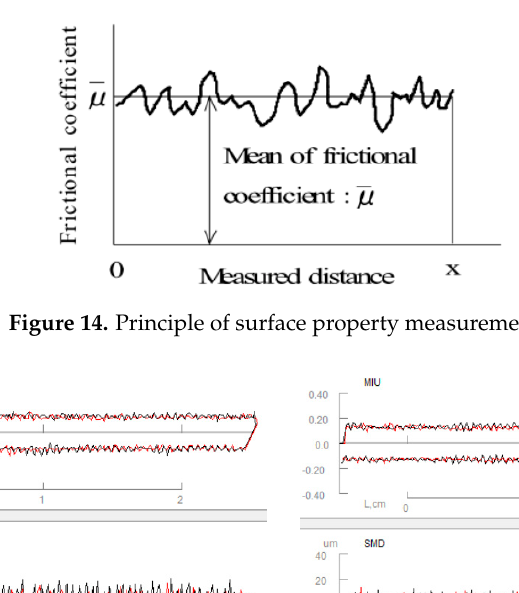
Figure 15. Surface property of ( a ) woollen fabric; ( b ) woollen fabric with interlining.